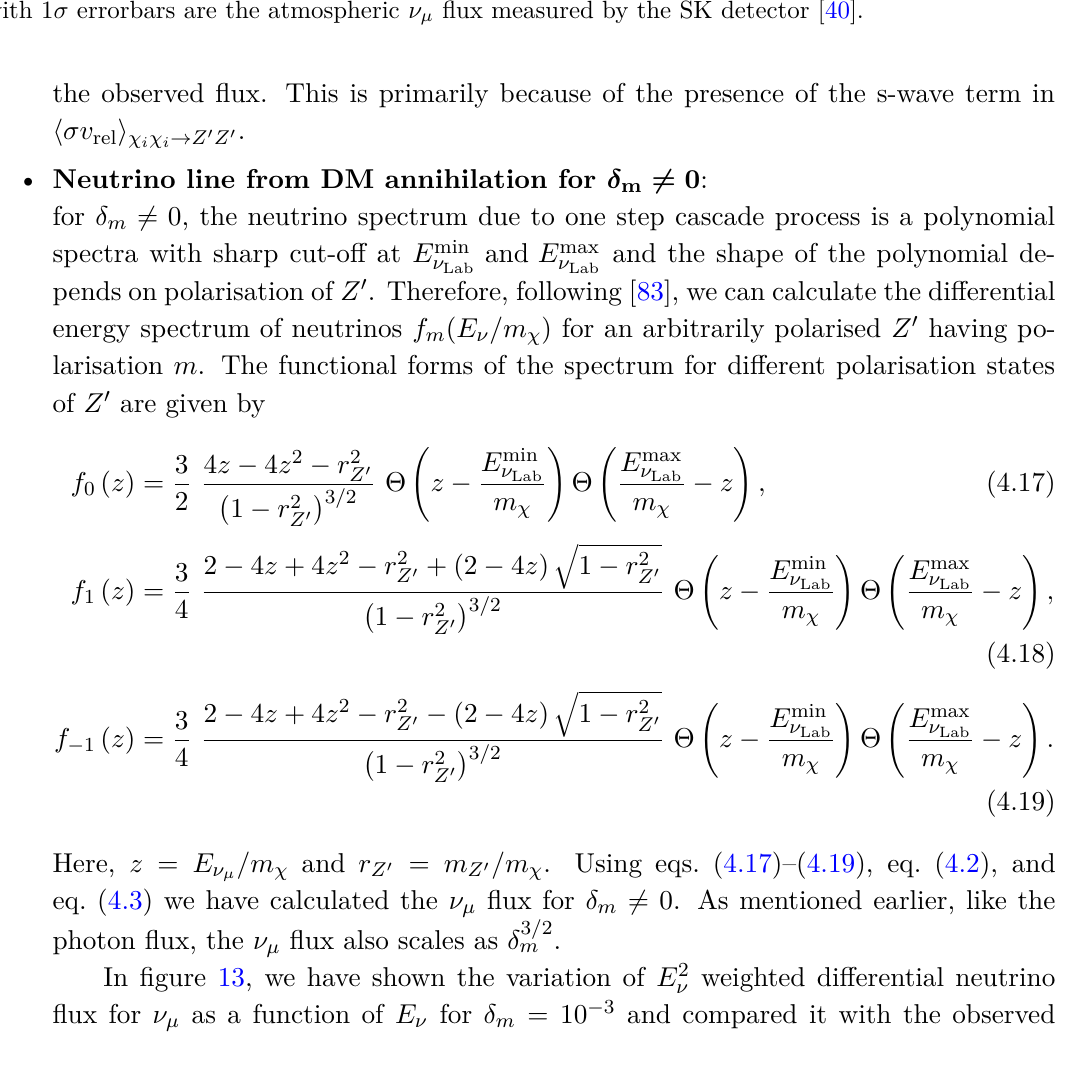
= 0 . 8 (blue line). The data points X